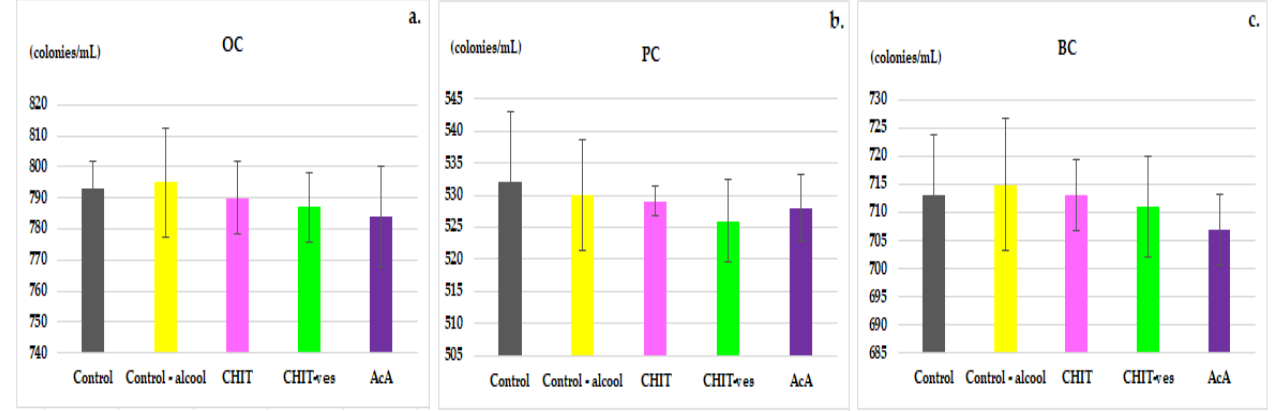
Figure 7. The effects of chitosan, chitosan vesiclesand ascorbic acid on the blood levels of OC ( a ), PC ( b ) and BC ( c ) in mice. The values are expressed as mean ± S.D. of the average values for 6 animals per group.